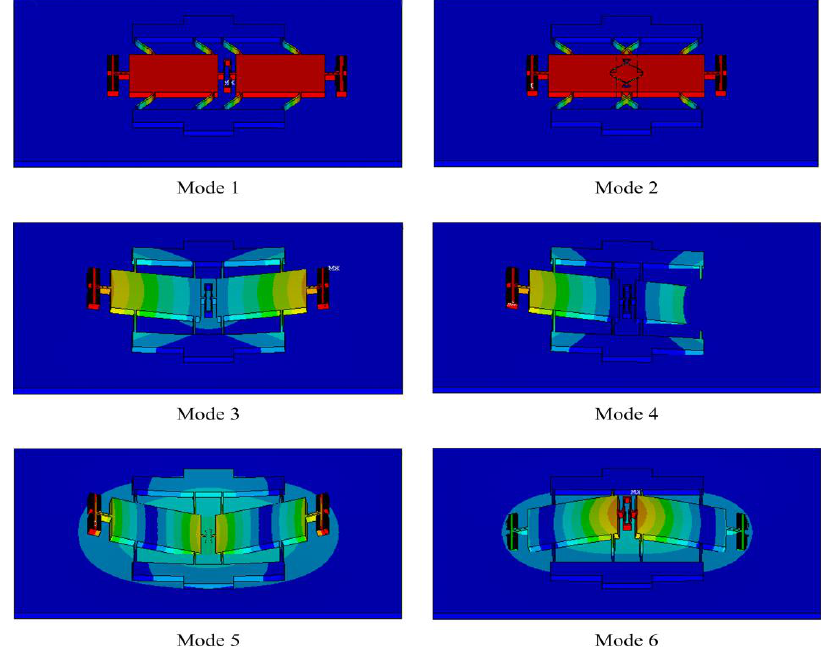
Figure 5. The first six vibration mode shapes of the resonant pressure sensor simulated using ANSYS.